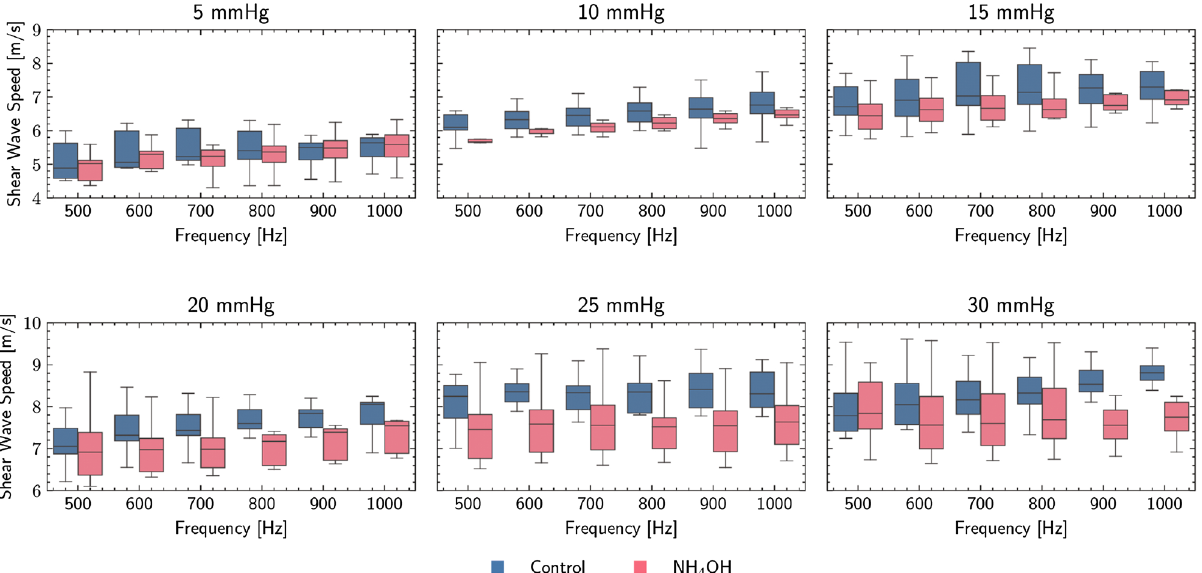
Figure 7. Torsional wave elastography (TWE) results: box plots of TWE dispersion curves differentiating each group. Two increasing trends are observed, the first with increasing frequency, and the second with increasing intraocular pressure (IOP). Ammonium hydroxide ( NH 4 OH) group exhibits lower values than the control group.